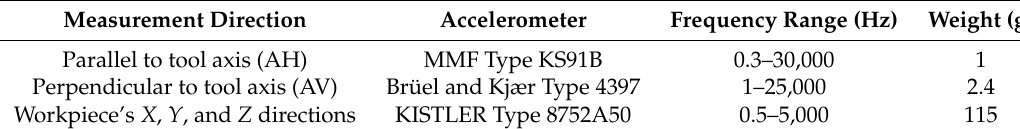
Table 1. Accelerometer set used in the sensorization of the machine–tool–workpiece setup.